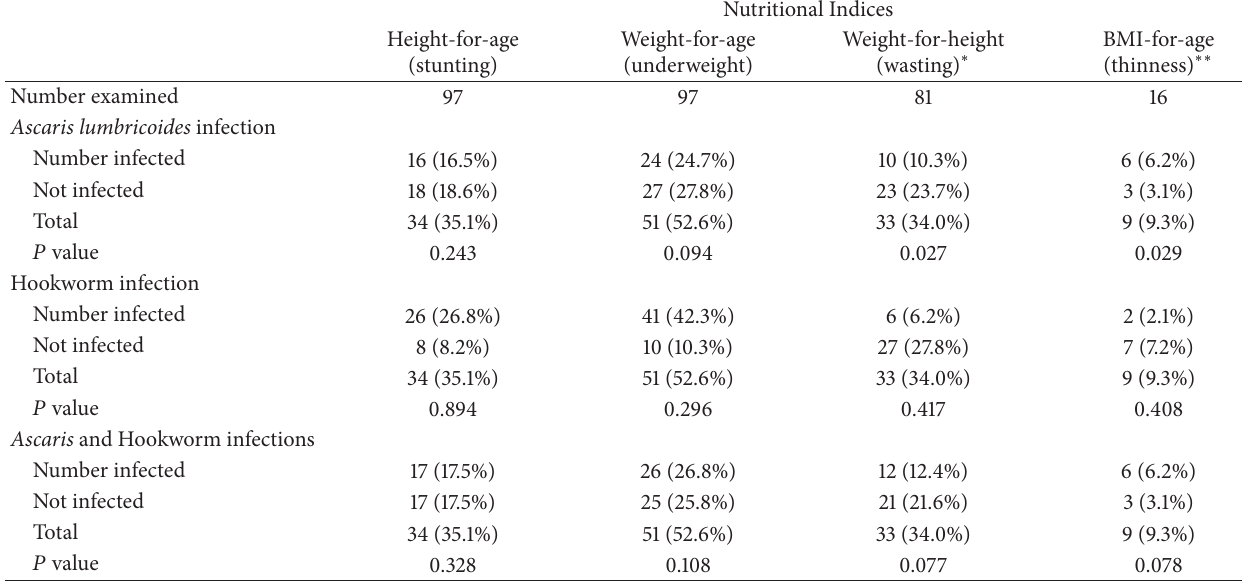
Table 7: Nutritional indices ( 𝑍 -score) and geohelminth infections of the surveyed preschool aged